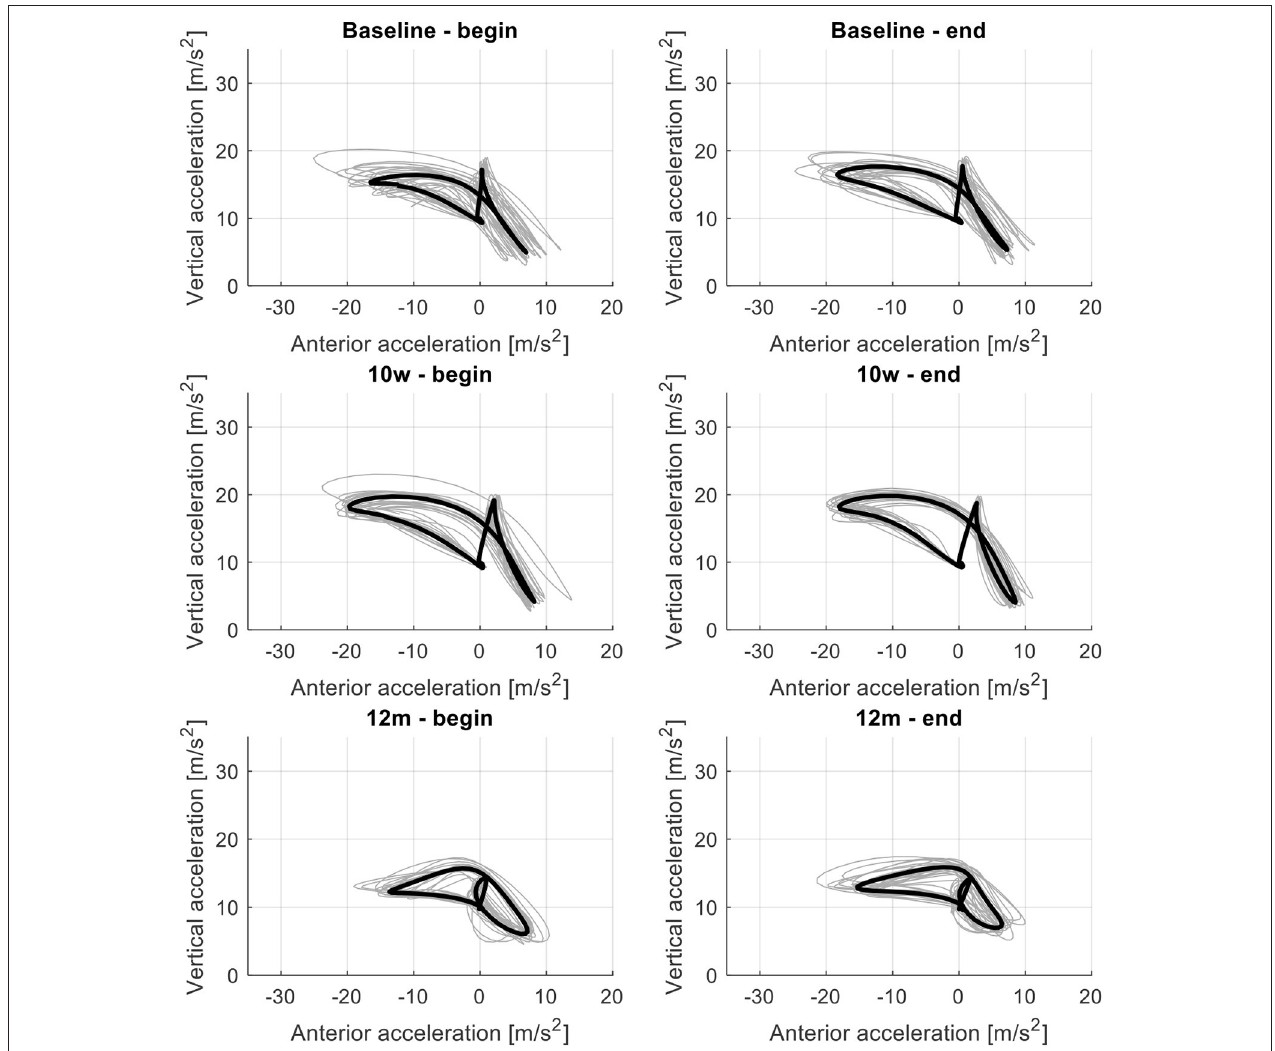
FIGURE 3 | The attractor (black line; mean of acceleration loops of all steps taken during 30m) and acceleration loops of all steps taken at the beginning (first 30m; left graph) and end (last 30m; right graph) of the 6-min walk test (gray lines) for the left foot for the assessments at baseline (Top) , 10-week follow-up (Middle), and 12-month follow-up (Bottom) exemplary for one patient with